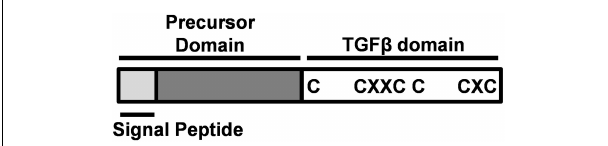
FIGURE 1 | Structure of Gonadal somatic cell-derived factor (Gsdf). Gsdf is composed of a signal peptide and a precursor domain, which are cleaved after protein processing. The mature TGF β domain is characterized by a cystine knot with three disulfide bonds. C, cystine; X, any amino acid.